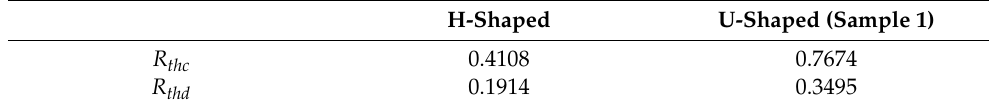
Table 4. Thermal resistances of corrugated SWTL (unit: m ◦ C/W).